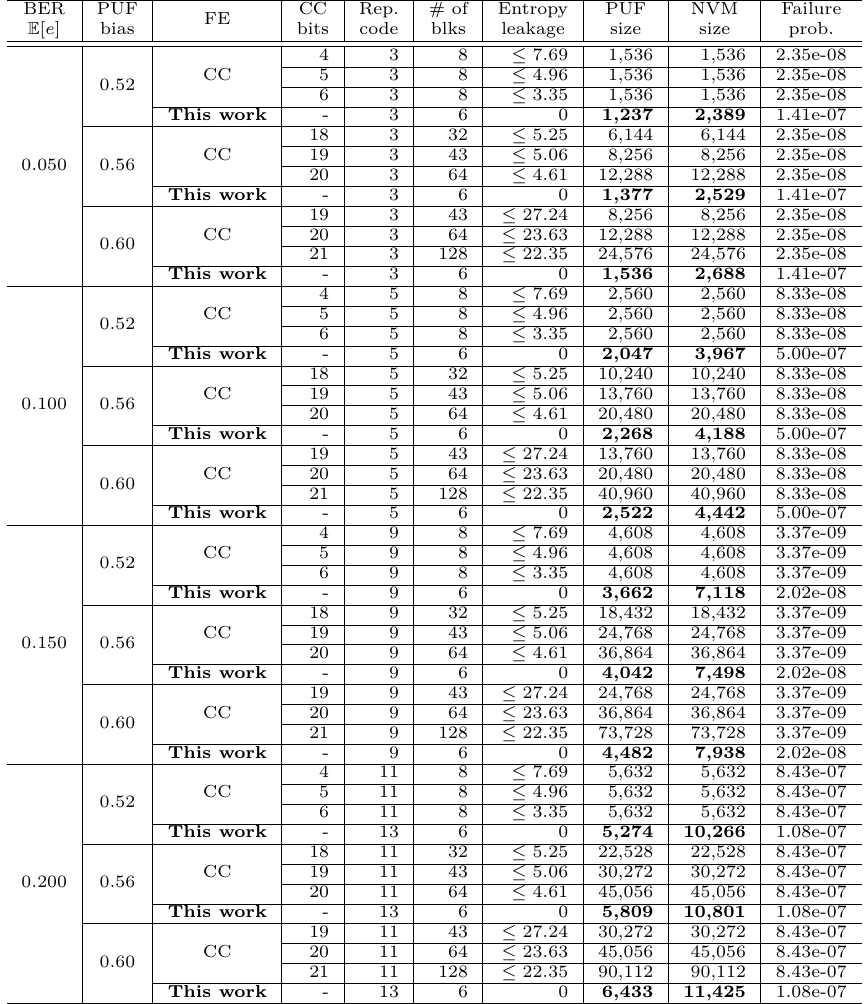
Table 10: Simulation results of key generation using 128-bit random seed with AR- and CC-based FEs (Values for CC-based FE are derived from